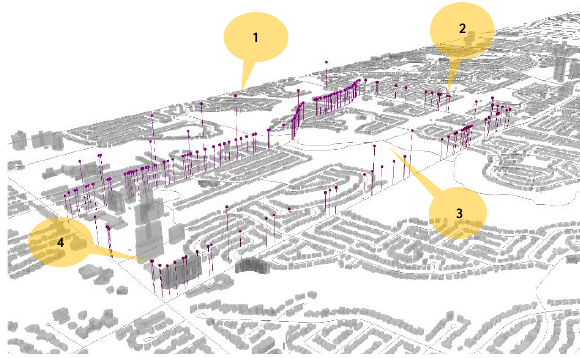
Figure 7. Outcomes of the spatiotemporal processing of the formed